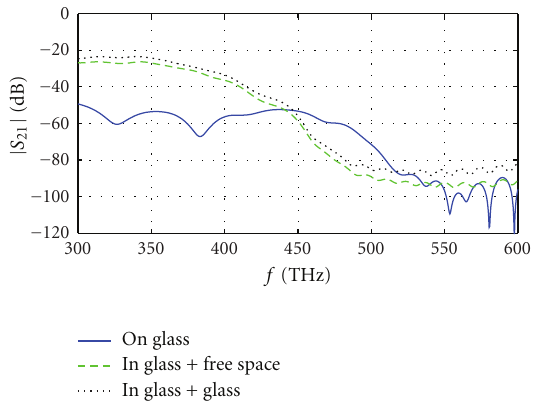
Figure 11: Transmission coe ffi cient | S21 | for three di ff erent scenarios of the optical wireless links from Figures 8–10. Distance between nanoantennas is 4 µ m.